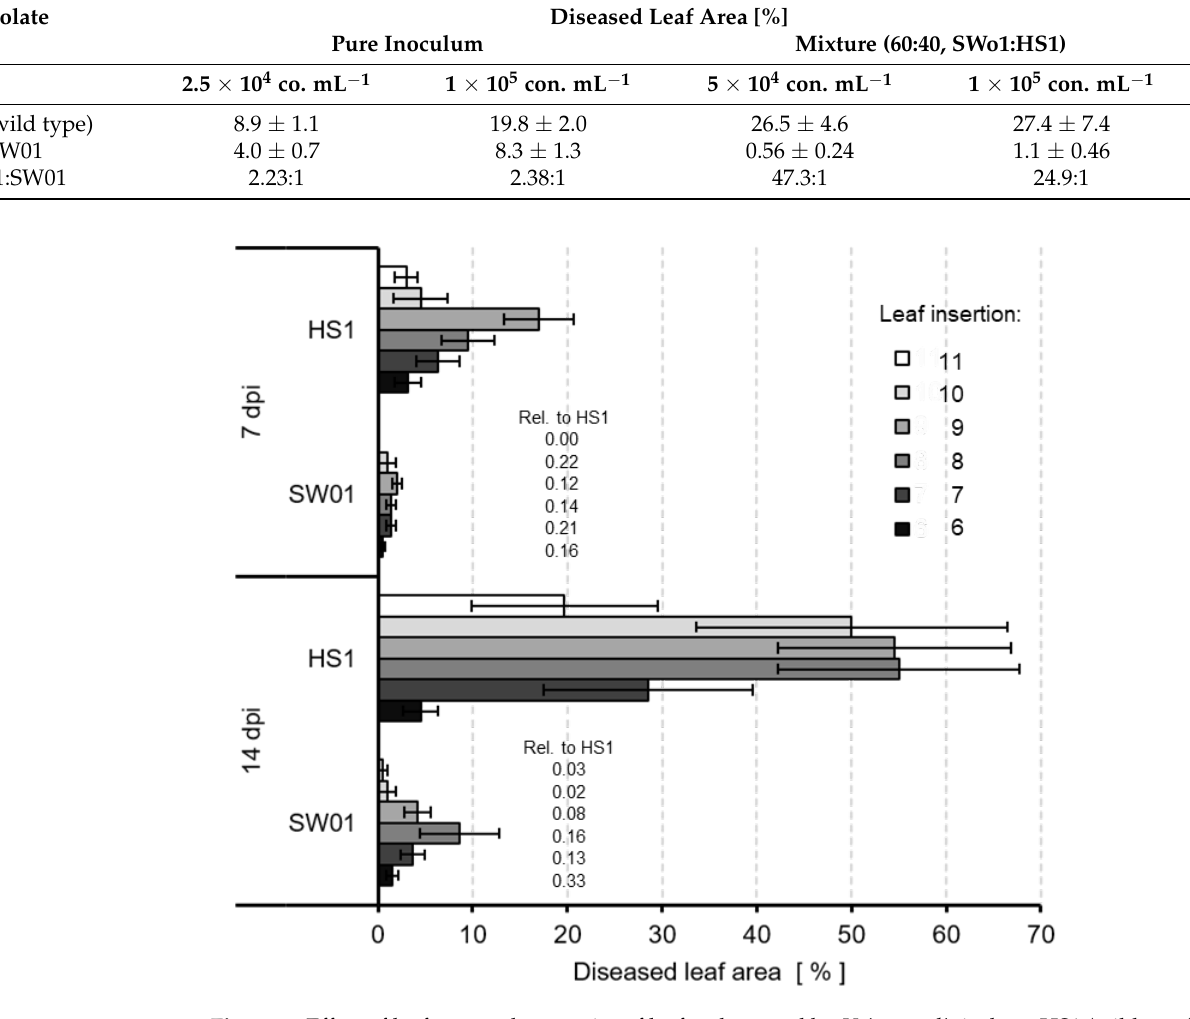
Figure 7. Effect of leaf age on the severity of leaf scab caused by V. inaequalis isolates HS1 (wild type) and SW01 (melanin-deficient mutant) 7 and 14 d p.i., respectively. Leaf insertion was counted from bottom to top. Bars indicate standard error of the mean (n = 6). The relative portion of SW01 on older leaves was higher than on the more susceptible, younger leaves.